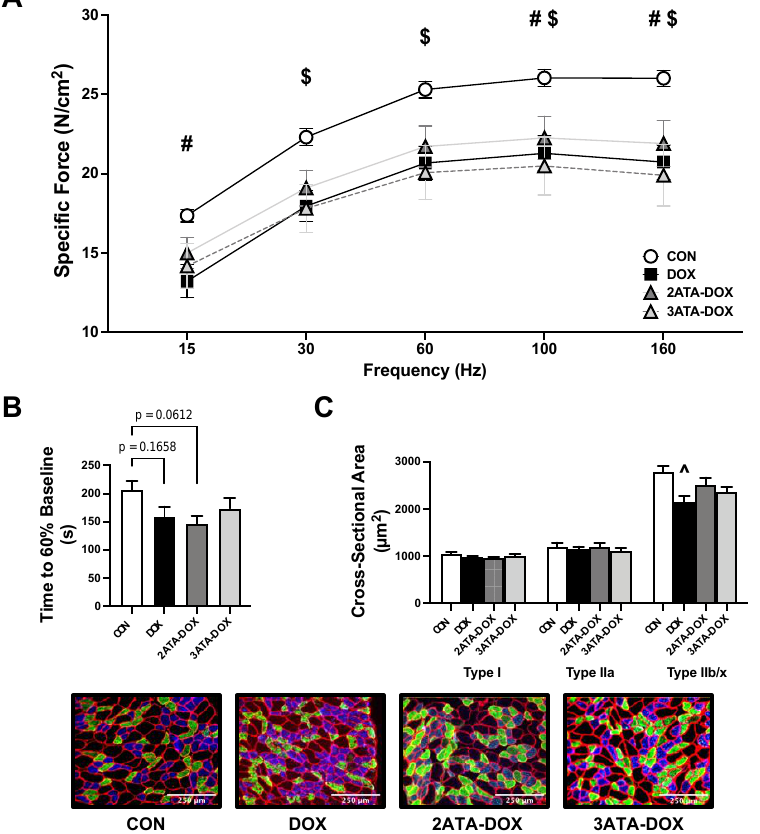
Figure 4. Diaphragm Function. Diaphragm measurement of ( A ) force-frequency response; ( B ) time to 60% of baseline force (fatigue); and ( C ) cross-sectional area of type I (blue), type IIa (green), and type IIb/x (black) fibers (representative images below). Values are represented as means ± SEM. # = CON significantly different vs. DOX ( p < 0.05). $ = CON significantly different vs. 3ATA-DOX ( p < 0.05). ^ = significantly different vs. CON ( p < 0.05).